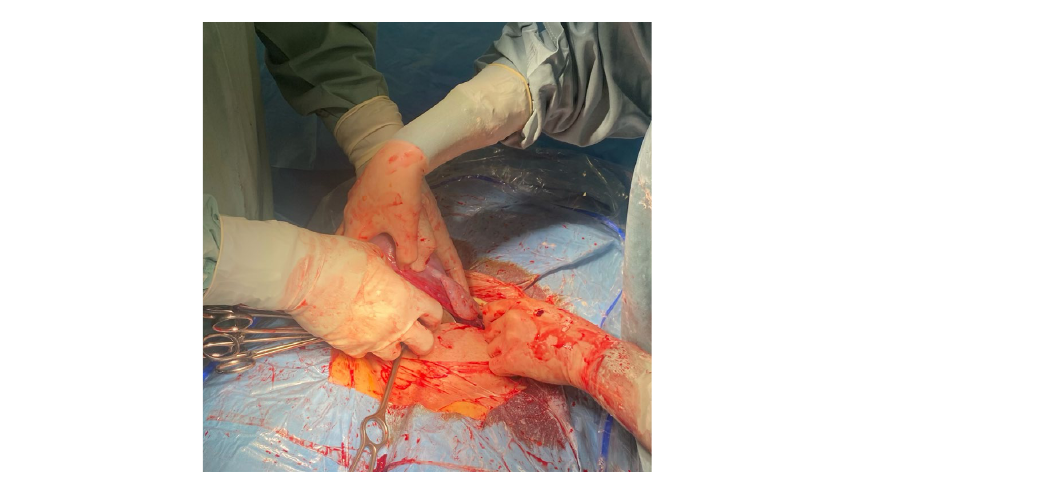
Figure 3. The assistant uses a sterile Foley catheter (Ch 16/18 French) to slide it down (caudally) to the lowest point, at the level of uterosacral ligaments.